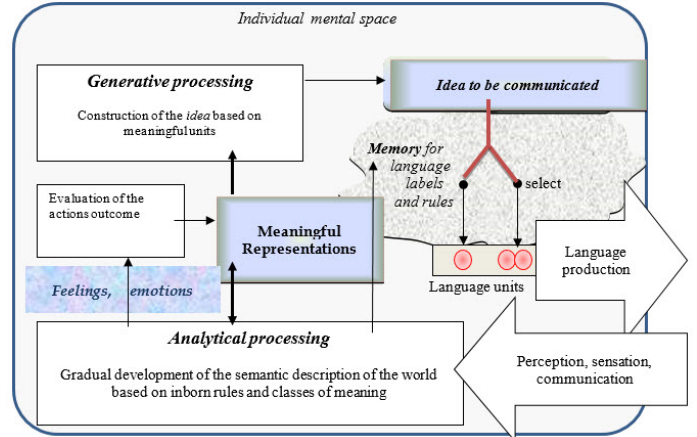
Figure 3. General scheme underlying the proposed